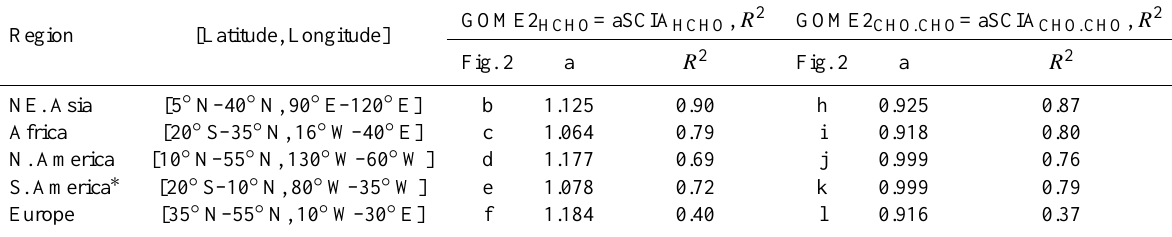
Table 1. Correlation between the column amounts of formaldehyde and glyoxal produced from the radiances of GOME-2 and SCIAMACHY instruments, over northeastern Asia, Africa, N. America, S. America and Europe. The highest square correlation coefficients, R 2 , were found over NE. Asia and the lowest over Europe. On average for the selected regions, an overestimation of the VCD HCHO and an underestimation of the VCD CHO . CHO are observed for the results based on the GOME-2 sensor in comparison to the SCIAMACHY ones. GOME2 HCHO = aSCIA HCHO , R 2 GOME2 CHO . CHO = aSCIA CHO . CHO , R 2 Region [Latitude, Longitude] Fig. 2 a R 2 Fig. 2 a R 2 NE. Asia 1.125